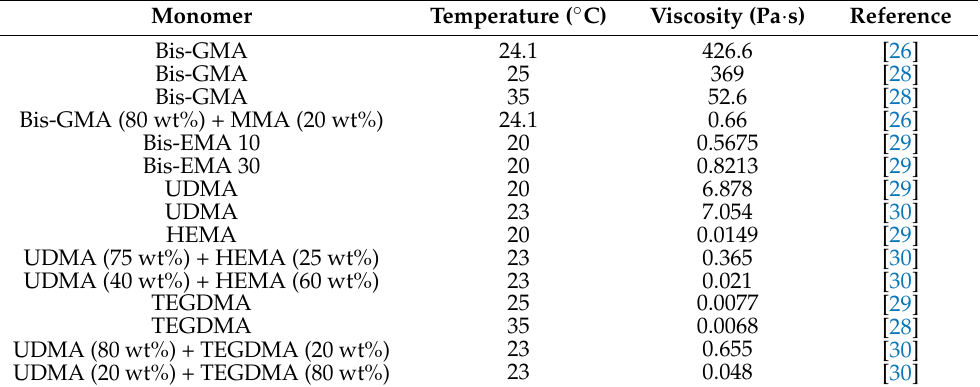
Table 1. Viscosity of monomers and different combinations for matrix of dental